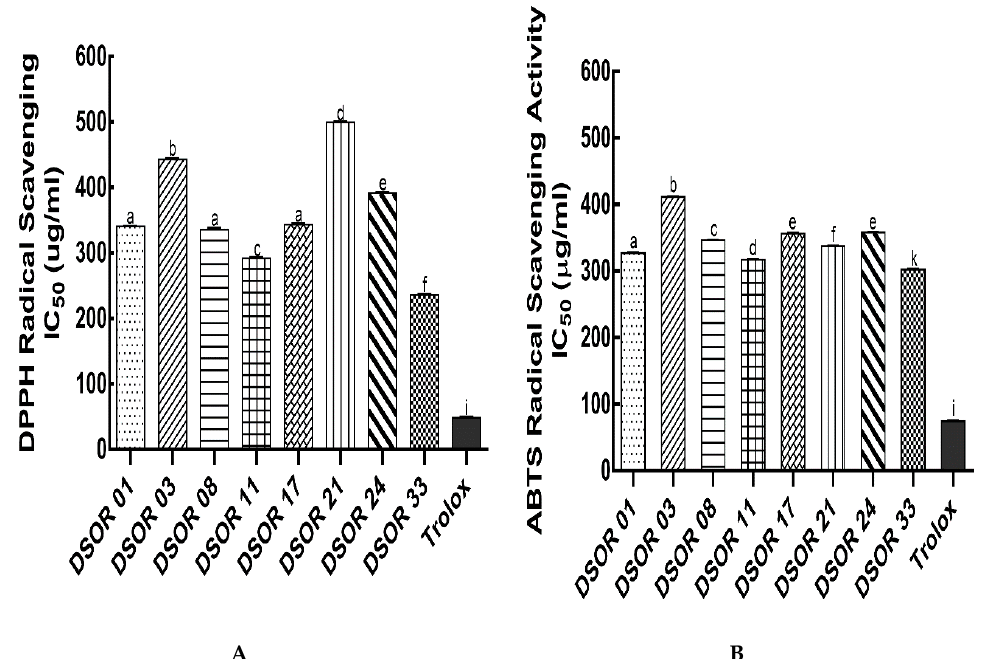
Figure 1. Antioxidant activities of soluble extracts of decorticated sorghum varieties. ( A ) 2,2 ′ - diphenyl-1-picrylhydrazyl (DPPH) radical scavenging activity IC 50 values; ( B ) 2,2 ′ -azino-bis (3-ethylbenzothiazoline-6-sulfonic acid) diammonium salt (ABTS) radical scavenging activity IC 50 values. Different lowercase letters denote significant difference ( p < 0.05).